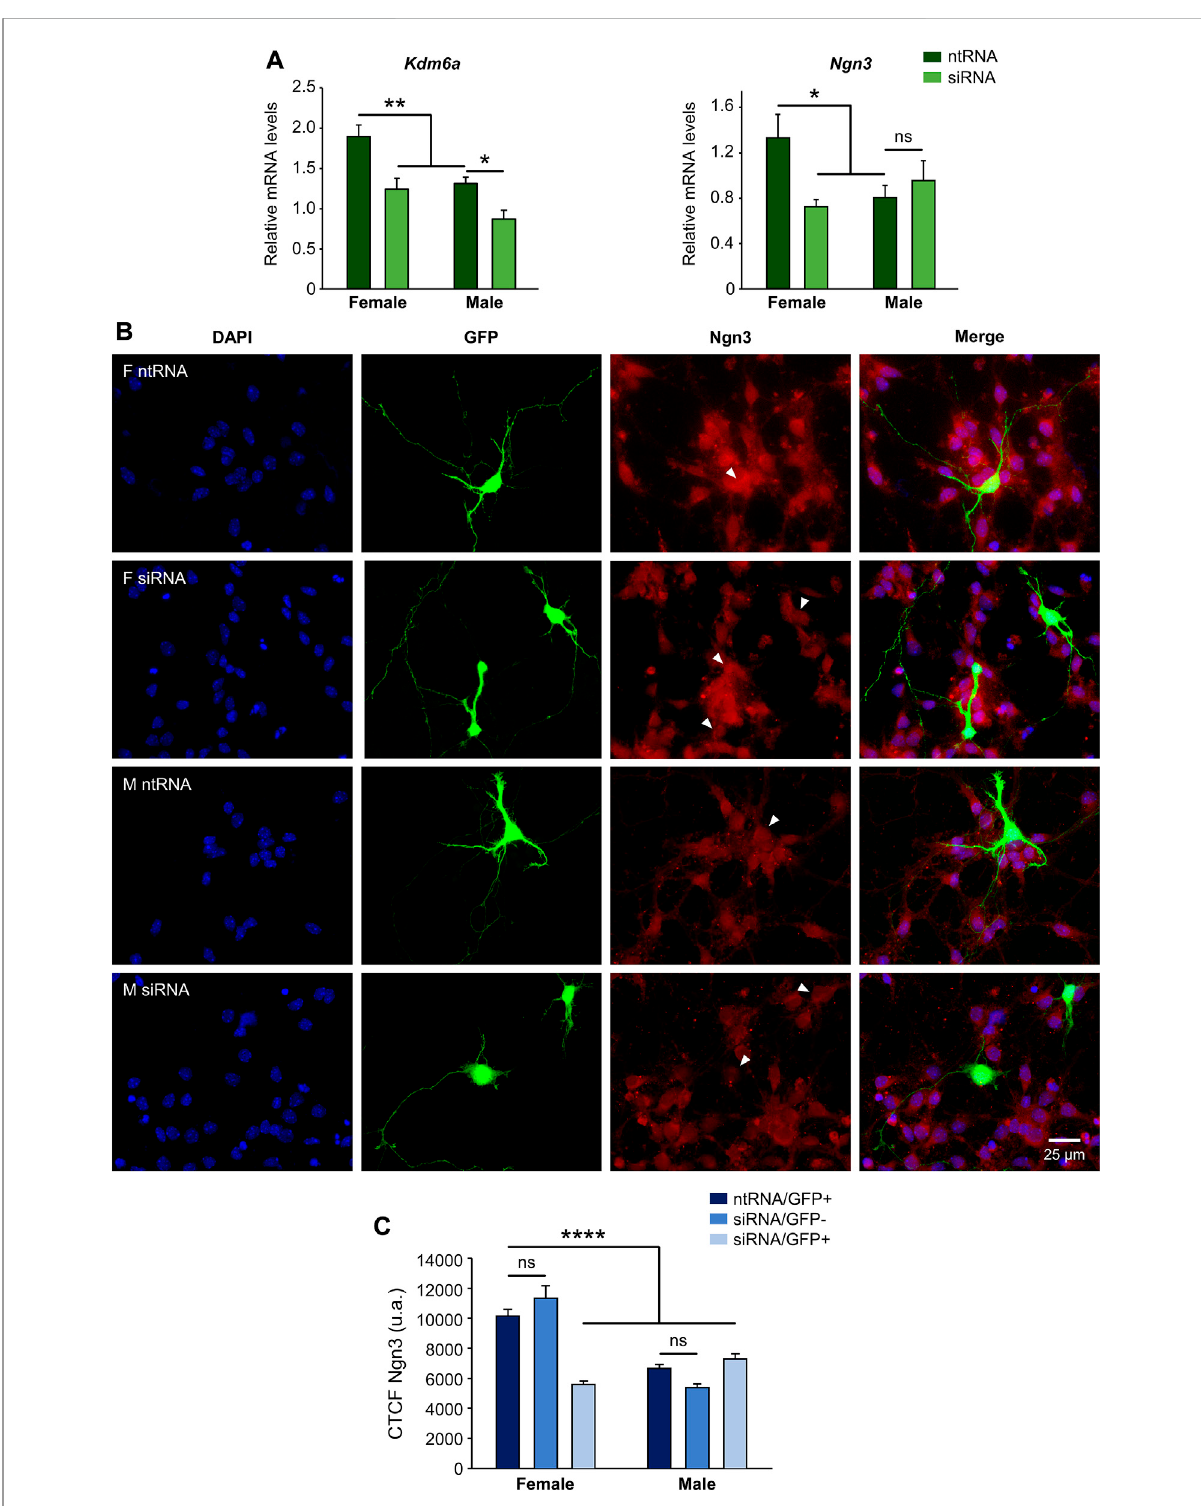
FIGURE 1 Kdm6aisrequiredforthesexuallydimorphicexpressionofproneuralNgn3. (A) Kdm6aknockdowneffecton Kdm6a and Ngn3 geneexpression analyzed by RT-qPCR in male- and female-derived hypothalamic neurons transfected with a control non-targeting siRNA sequence (ntRNA) or siRNA targeting Kdm6a (siRNA). Kdm6a and Ngn3 showed higher expression levels in female than in male neurons under control conditions. siRNA targetingKdm6awaseffectiveindownregulating thedemethylasemRNAlevelsinbothmaleandfemaleneurons.Kdm6aknockdownbysiRNA decreased Ngn3 mRNA levels only in female neurons. (B) Representative fl uorescence images of female (F) and male (M) hypothalamic neurons co-